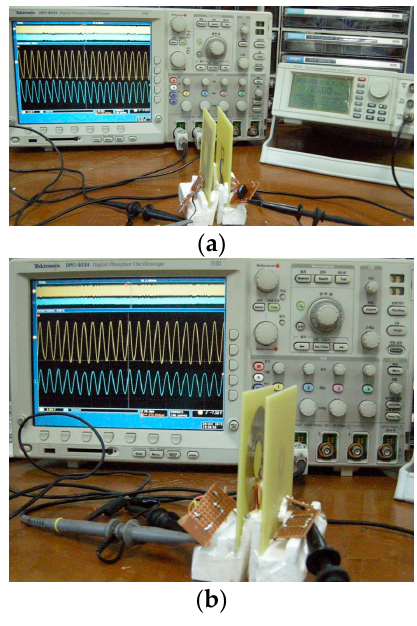
Figure 14. Experimental setup. ( a ) Square coil; ( b ) Circular coil.